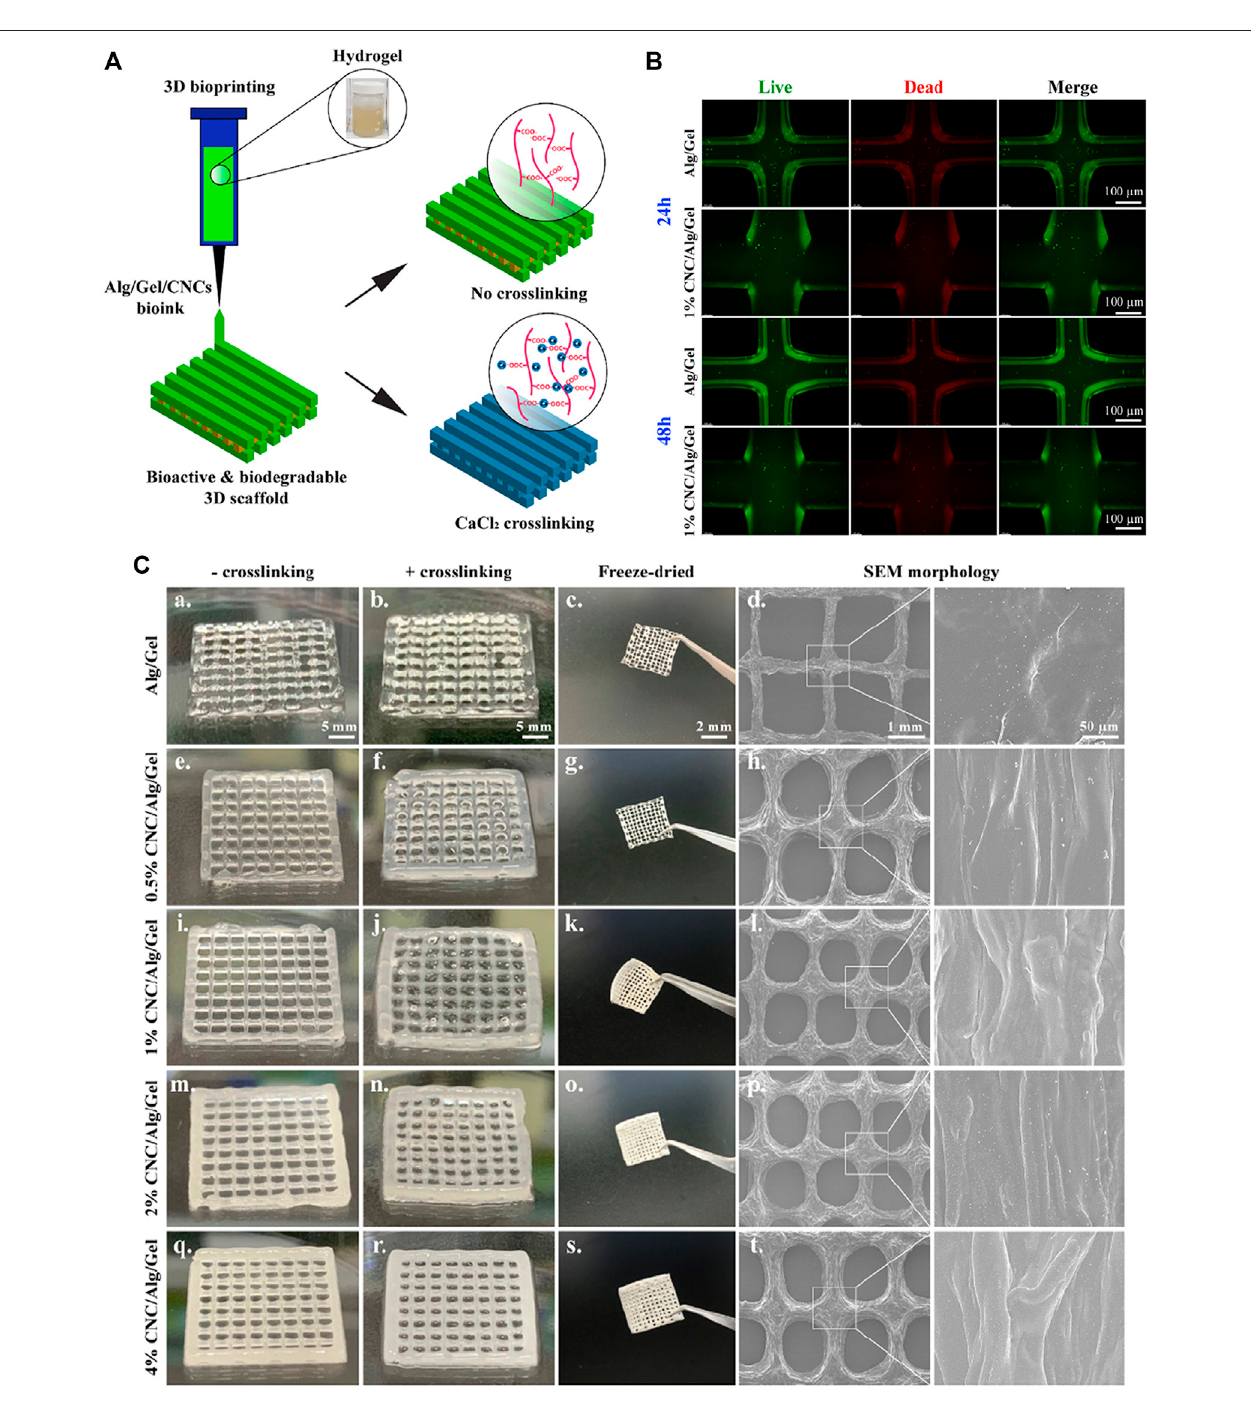
FIGURE 5 | (A) Schematic representation of 3D bioprinting using Alg/Gel/CNCs hydrogels for tissue engineering; (B) Images of Live/Dead assay of 3D bio-printed cell-laden constructs (Alg/Gel and 1% Alg/gel) at indicated time intervals; (C) Digital photographs showing the un-crosslinked, crosslinked, and fridge-dried scaffolds after 3D printing; SEM images showing the internal structure of printed scaffolds. Reproduced from Dutta et al. (2021) with permission from Copyright 2021 Elsevier.